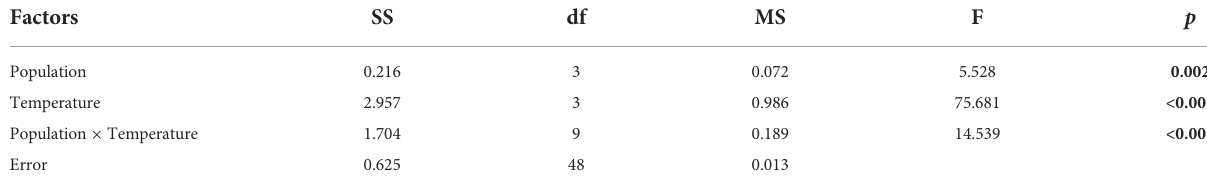
TABLE 2 Two-way ANOVA for the effects of population and temperature on the gametophyte density of Laminaria ochroleuca after 38